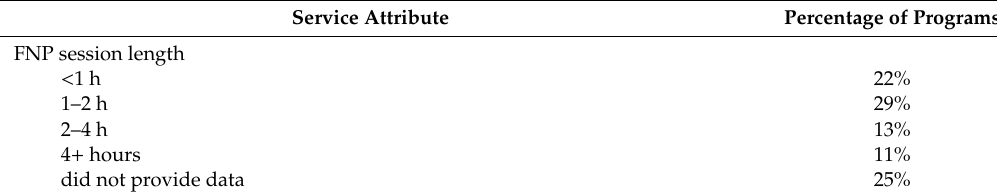
Table 5. Service Attributes of Food and Nutrition Education Programs (FNPs) ( n = 101